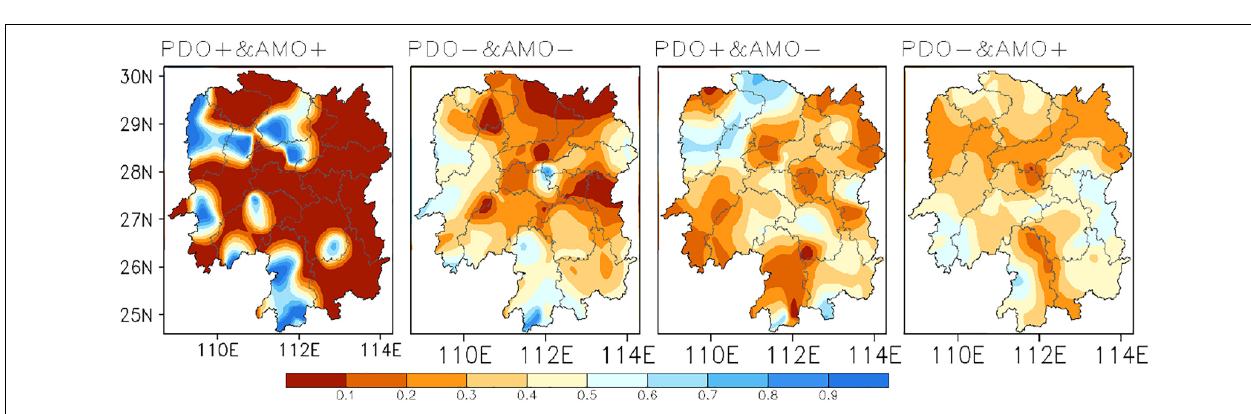
FIGURE 7 | The same as Figure 4 , but for the next years of La Niña